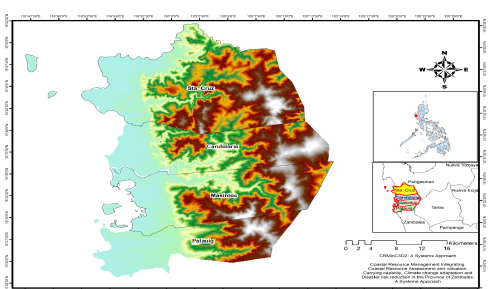
Figure 3. Elevation map of the study area